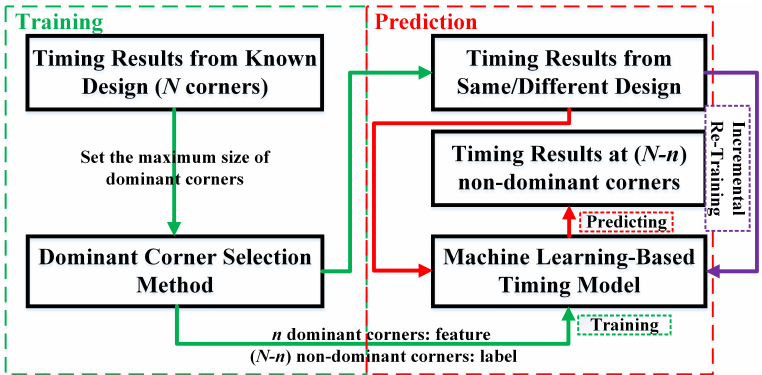
Figure 5. Machine-learning-based timing prediction application flow.